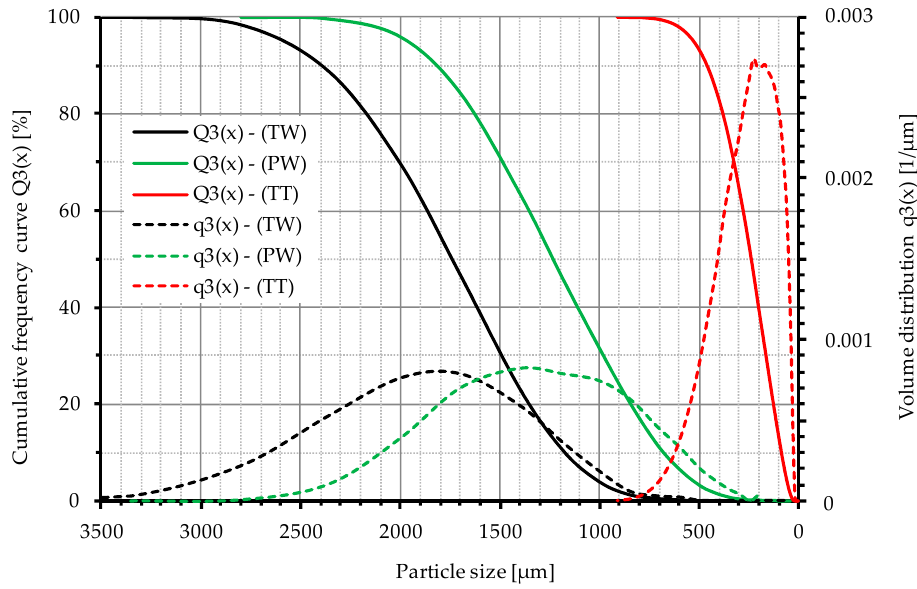
Figure 1. Particle size distribution of rubber recyclates from end-of-life tires, TW: whole truck tires, TT: truck tire tread, PW: passenger car tires.